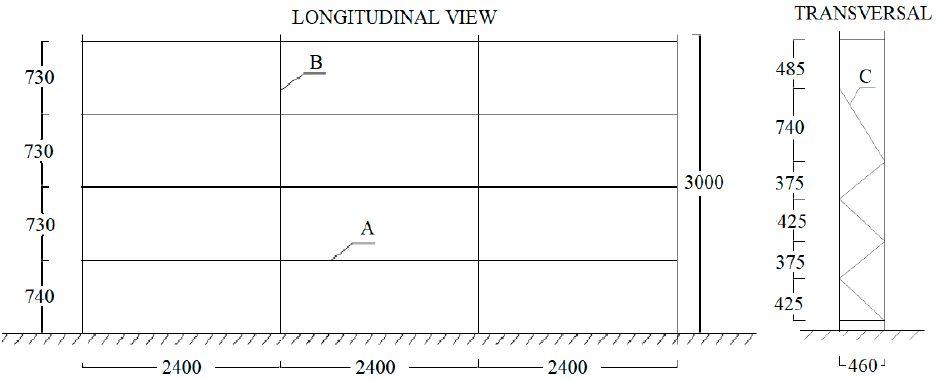
Figure 4. Scheme of the considered rack, dimensions in millimeters.